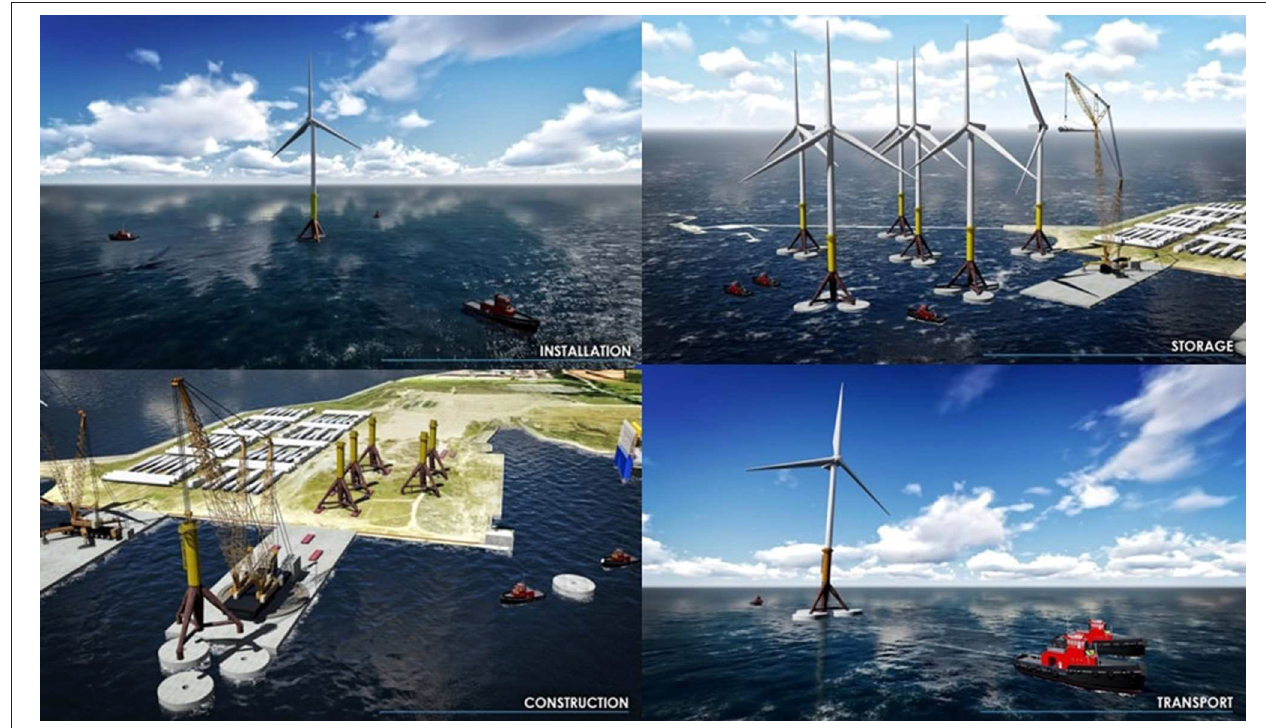
FIGURE 9 | GRAVI3 ® Supply Chain.